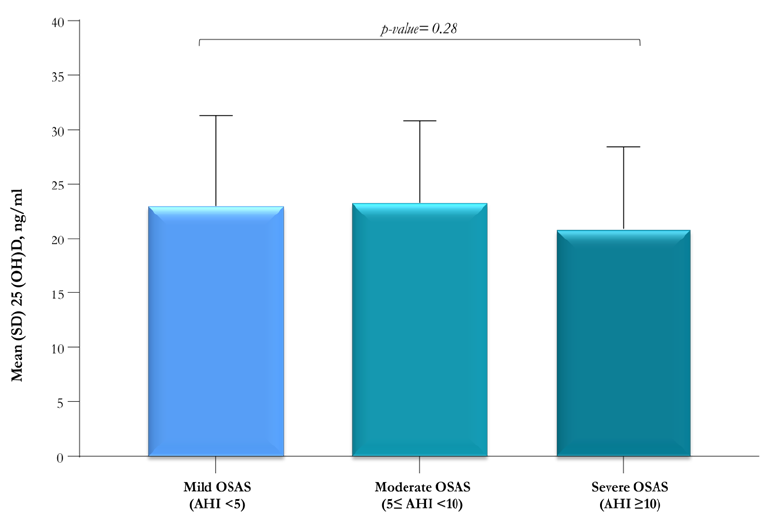
Figure 2. Serum 25(OH)D levels in subjects with mild (AHI < 5), moderate (5 ≤ AHI < 10), and severe (AHI ≥ 10) OSAS.